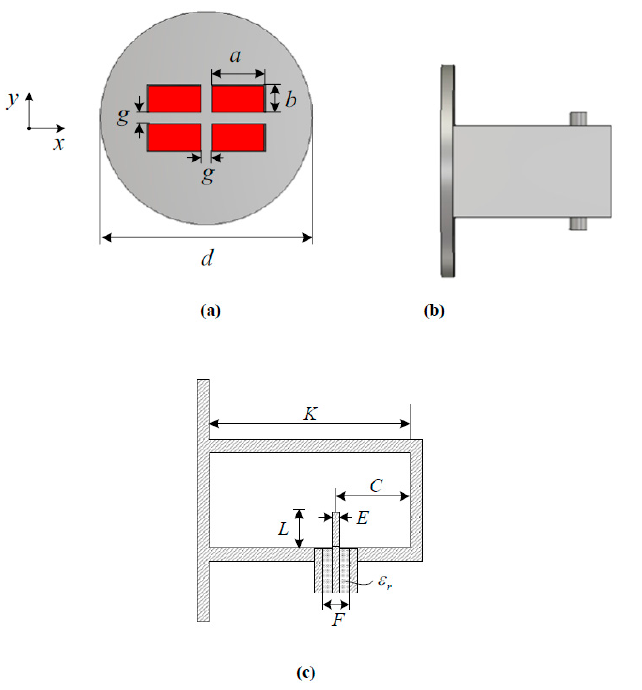
Figure 1. Dimensional parameters of the designed feed. ( a ) Front view. ( b ) Side view. ( c ) Probe di- mensions.